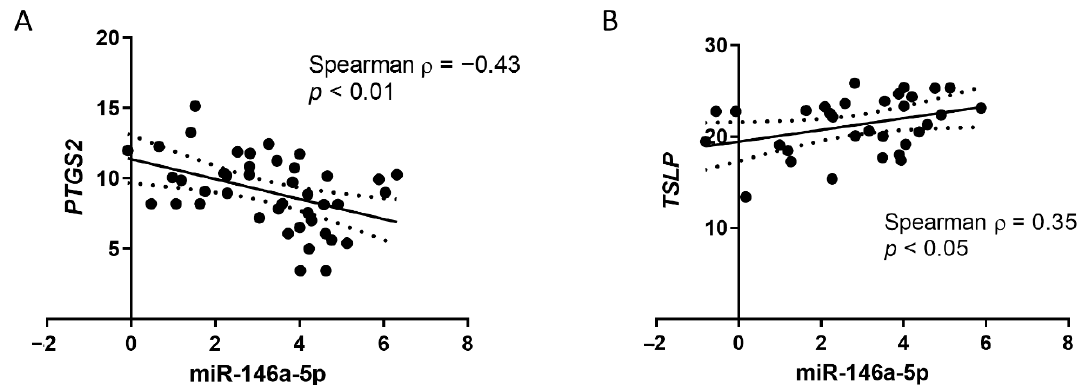
Figure 2. miR-146a-5p correlates with genes involved in immune responses. ( A ) Gene expression correlation (2 −Δ Ct ) of miR-146a-5p and PTGS2 in NPA cells from infants with respiratory diseases. ( B ) Gene expression correlation (2 −Δ Ct ) of miR-146a-5p and TSLP in NPA cells from infants with respiratory diseases. Lines indicate linear regression and dotted lines indicate 95% confidence bands of the best-fit line.